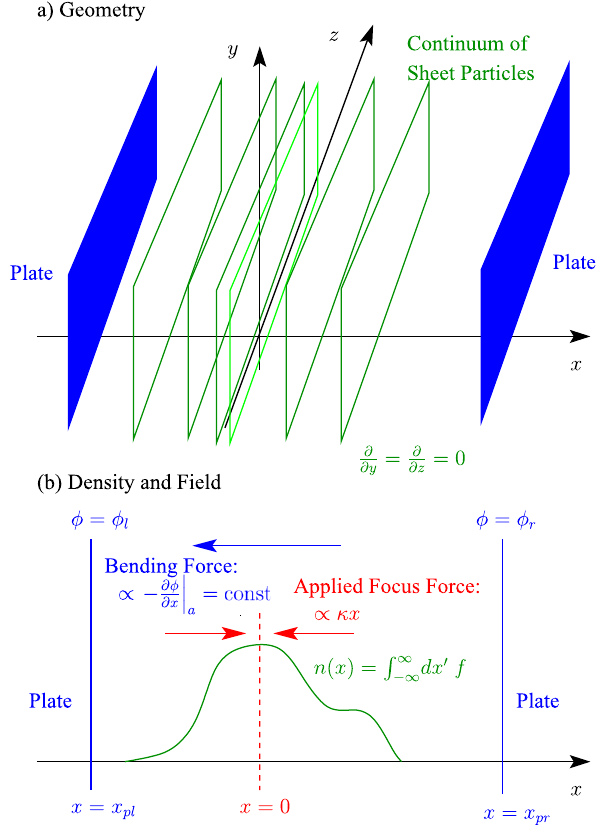
FIG. 1. Schematic of 1D sheet beam (a) geometry with biased conducting plates and (b) density projection and